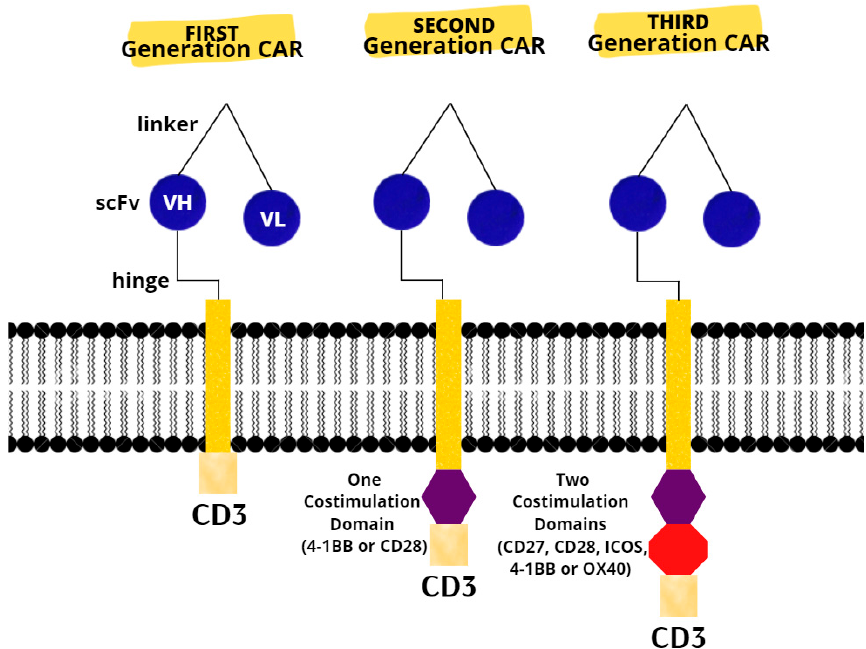
Figure 1. Chimeric antigen receptors. Next-generation CARs have additional modifications to their intracellular stimulatory domains. CD3, cluster of differentiation 3; ICOS, Inducible T-cell costimulator; scFv, single-chain fragment variable; VH, heavy chain variable gene segment; VL, variable region.